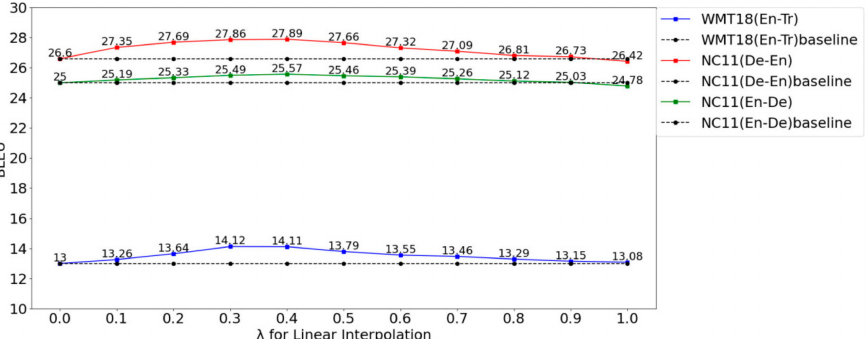
Figure 4. BLEU scores of the Linear Interpolation method on the WMT18 (EN-Tr), NC11 (En–De) and NC11 (De–En) test sets with different values of λ . The dashed line denotes the result of the